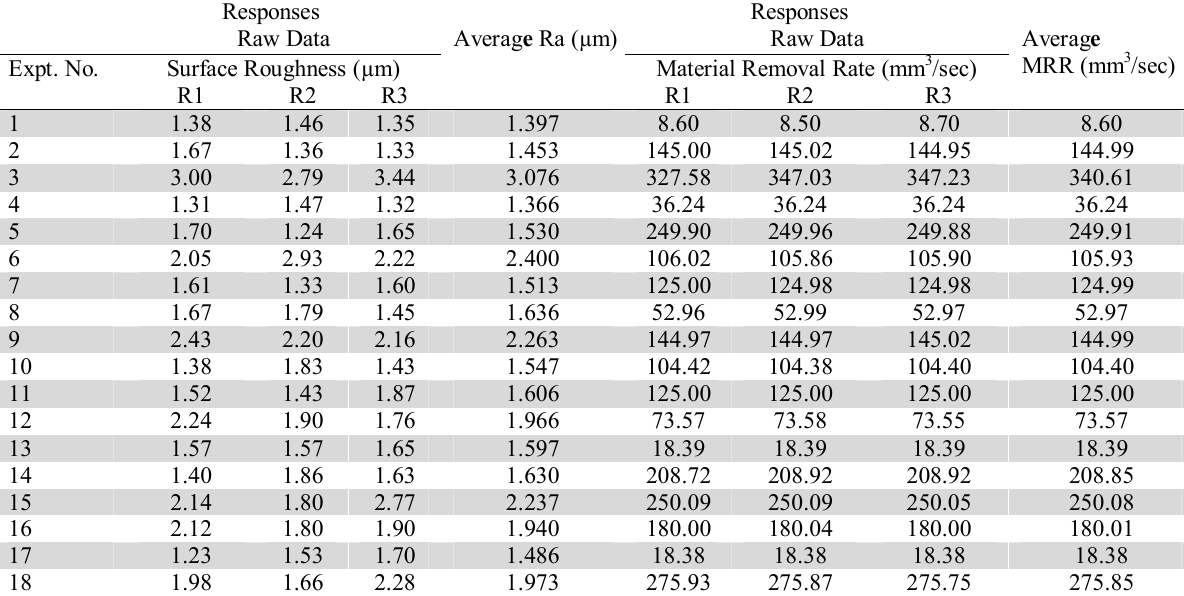
Test Data Summary for Surface Roughness and Material Removal